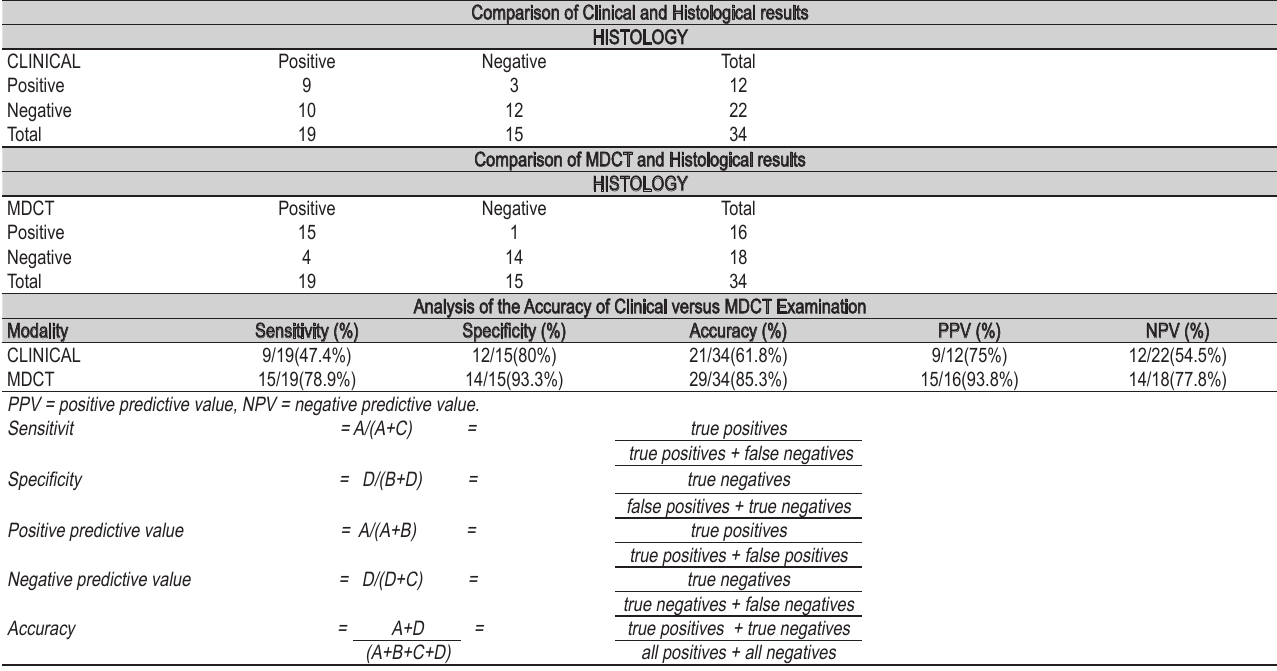
Table 3 - Comparison of the accuracy of Clinical and MDCT detection of nodal